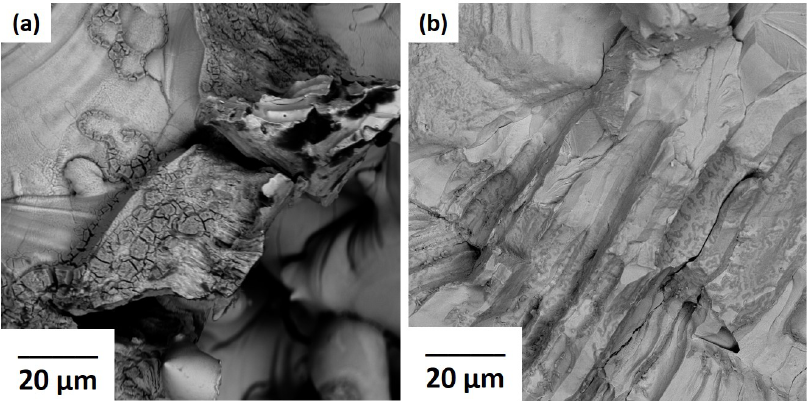
Figure 10. Magnified backscattered electron SEM images of fracture surfaces for ( a ) pure molybdenum and ( b ) Mo-0.1SiC printed at 200 and 800 mm/s, respectively.